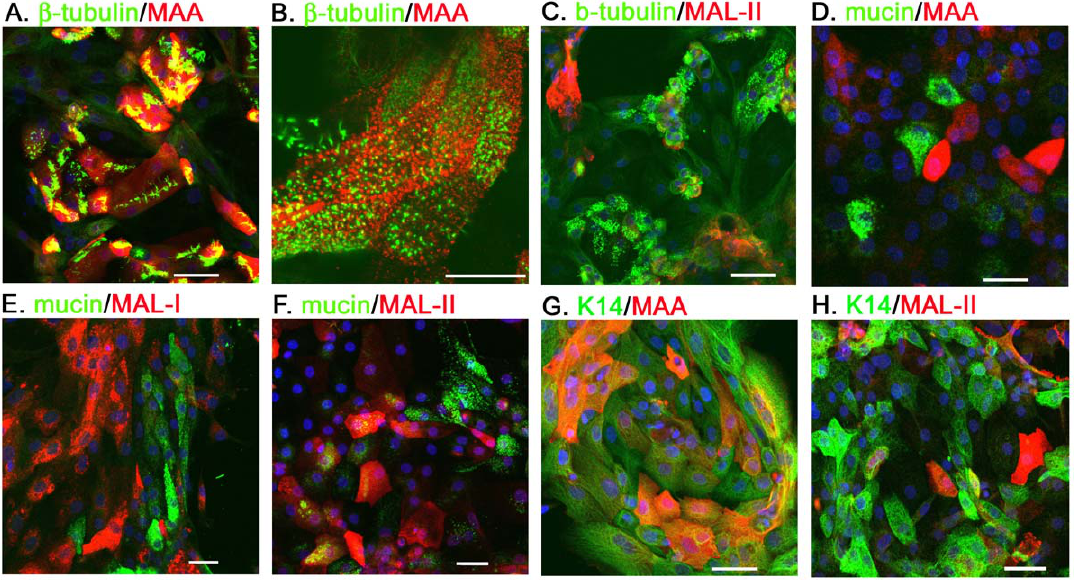
Figure 1. The SA a 2–3Gal expression of primary CTE cells. The ciliated cells, goblet cells and basal cells were revealed by their specific markers: the b -tubulin (A–C), mucin (D–F) and K14 (G, H), respectively. The cellular distribution of SA a 2–3Gal was characterized by the double-staining of biotin-labeled MAA (EY Laboratories, 1:500) (A, B, D, G), MAL-1 (E) or MAL-II (both from Vector laboratories, 1:500) (C, F, H). Scale bar, 50 m m.